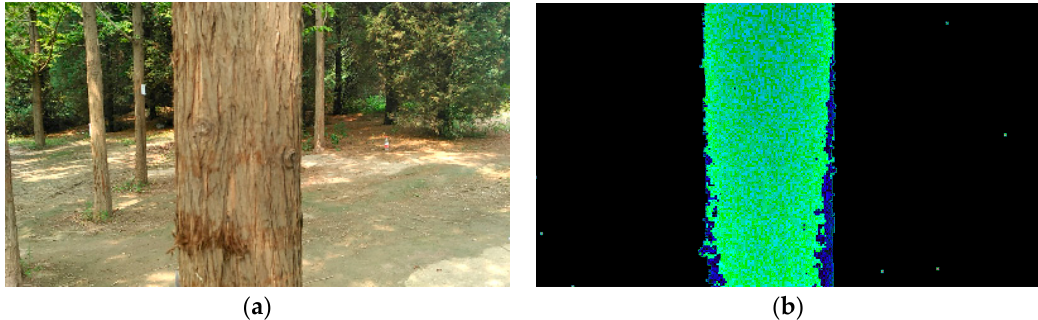
Figure 8. The RGB image and depth image used to calculate the stem position and DBH: ( a ) the RGB image; ( b ) the Depth image.